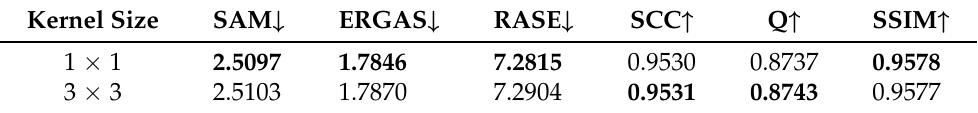
Table 5. Ablation study of different kernel sizes on the Ikonos